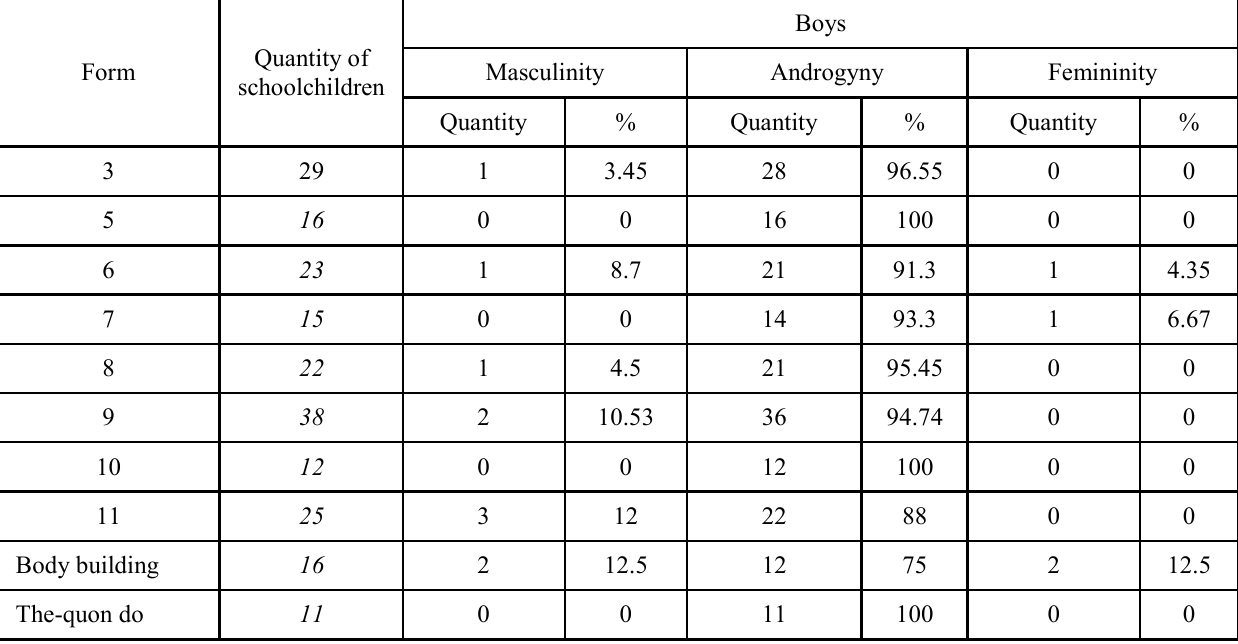
Results of gender identity’s research (by